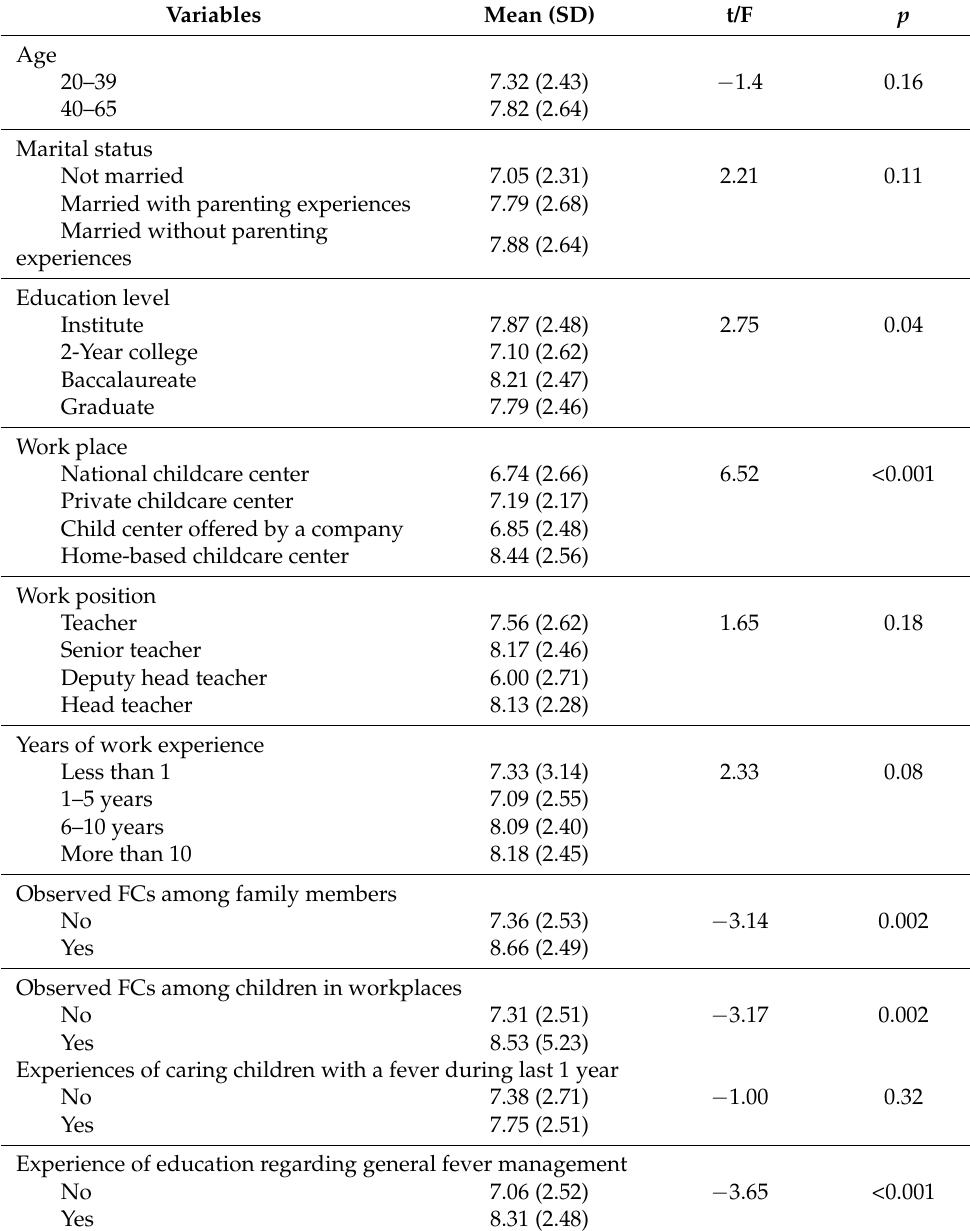
Table 3. Febrile convulsion practices according to demographic characteristics ( n = 216).